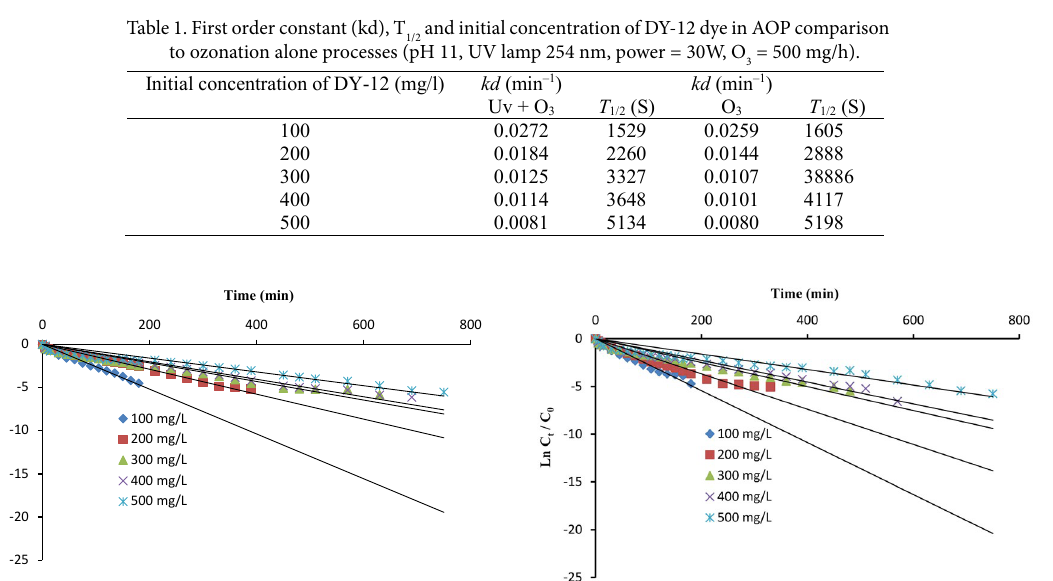
Fig. 7. Kinetics of the Direct Yellow 12 ozonation (O mg/h, treated volume = 200 ml, initial solution pH 9).